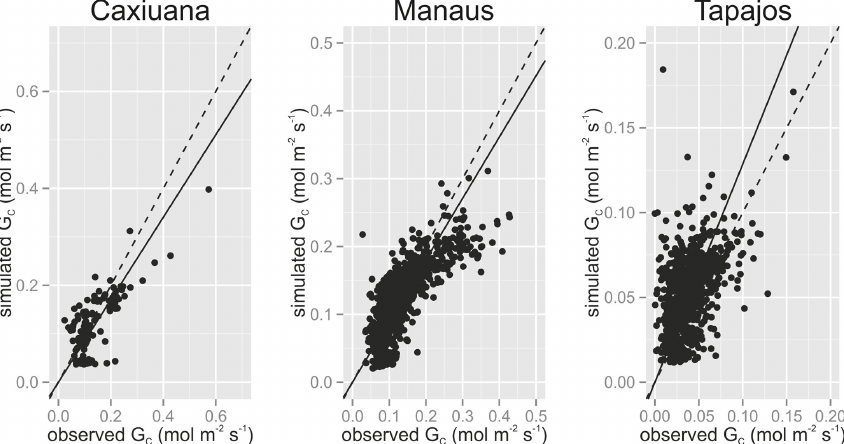
Figure 3. Simulated against observed mean daily canopy conductance G C for the three sites with eddy flux data. The broken line represents a 1 : 1 relationship and the continuous line illustrates a standardised major axis (SMA)